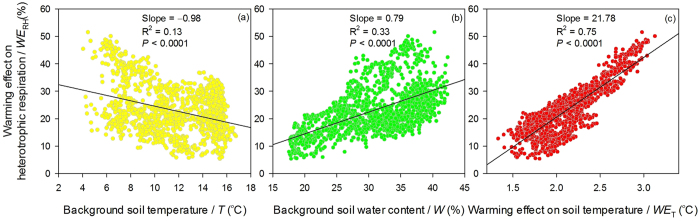
Relationships between WERH and T (a), W (b), and WET (c).